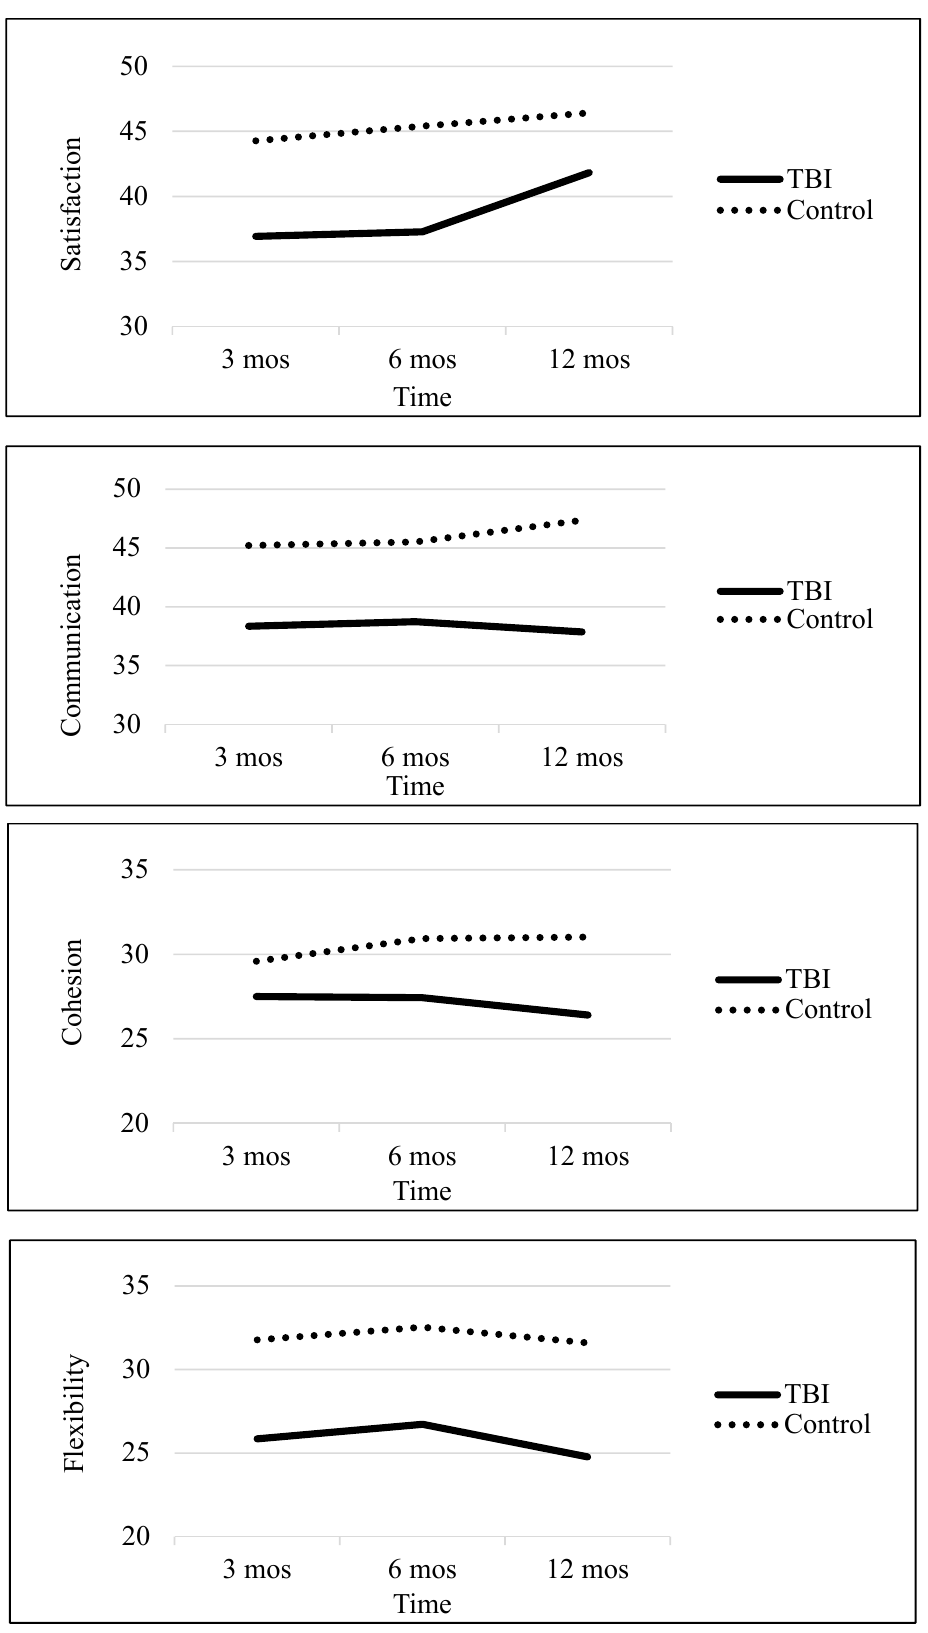
Figure 1. Graphs of Family Functioning Measures over Time by Group.